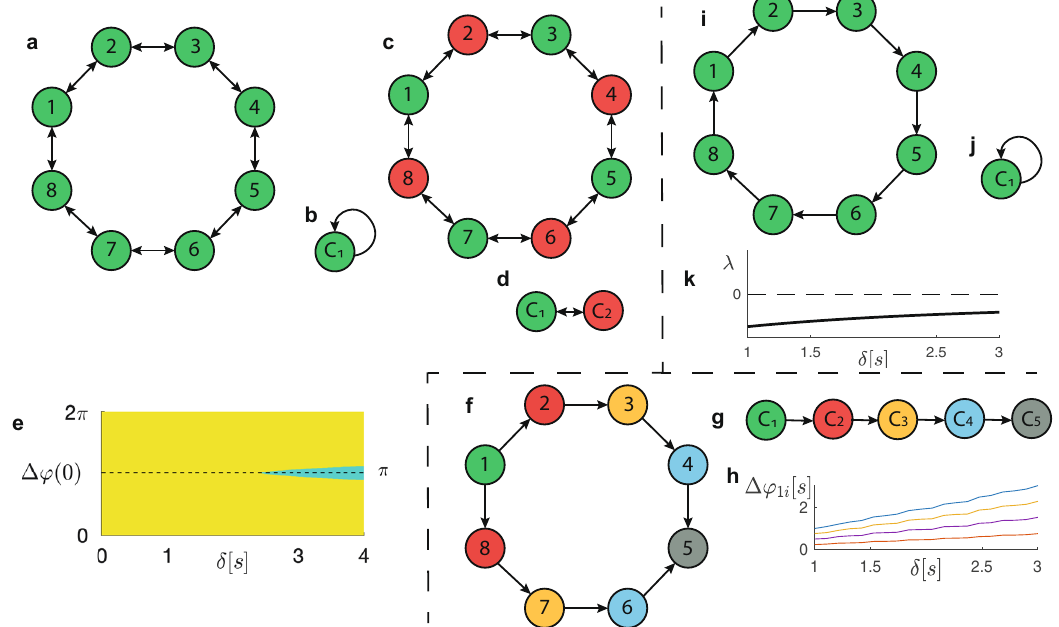
Fig. 6 Example 1: ring of 8 violin players. For delay δ < 1 s or 3 < δ < 4 s, the network of violin players can be represented as undirected ( a – d ), and for 1 s < δ < 3 s as a directed network with “ arrowhead ” topology, oriented either clockwise (as in f , g , i , j ) or counterclockwise. a Undirected network with minimal balanced coloring ( “ in-phase ” global synchronization pattern). b Corresponding quotient network. c Undirected network with (non-minimal) balanced coloring. d Corresponding quotient network. e Basins of attraction of the two stable solutions admitted by the quotient network ( d ): “ in-phase ” global synchronization (yellow region) and “ out-of-phase ” synchronization with two clusters oscillating in antiphase (green region). f Directed network with “ arrowhead ” topology and balanced coloring. g Corresponding quotient network. h Asymptotic phase differences Δ φ linearly with δ . i Directed network with “ arrowhead ” topology and minimal balanced coloring. j Corresponding quotient network. k MLE λ corresponding to this synchronization pattern, showing stability as λ ( δ ) < 0 for any δ ∈ (1,